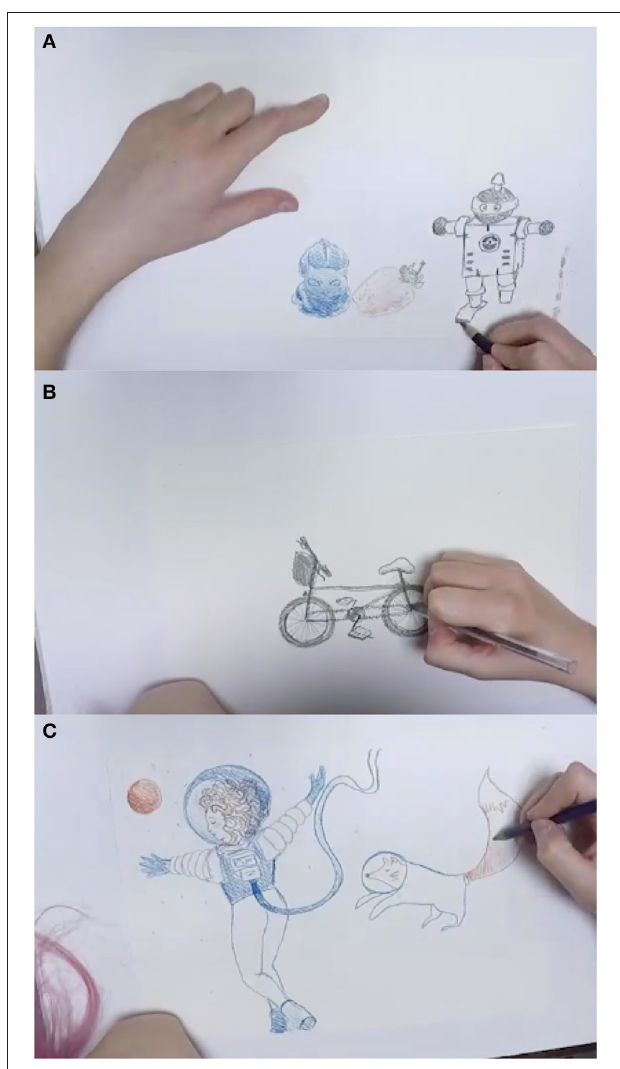
FIGURE 7 | Drawing exercises in progress for a single study participant, showing (A) still life drawing, (B) drawing from mental image, and (C) free drawing.